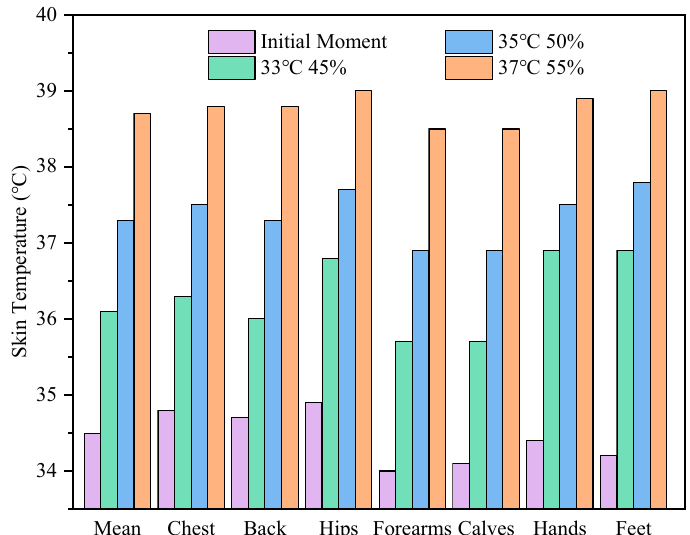
Figure 4. The predicted mean and local skin temperatures of grid workers at the initial and final moments of work in different hot environments.